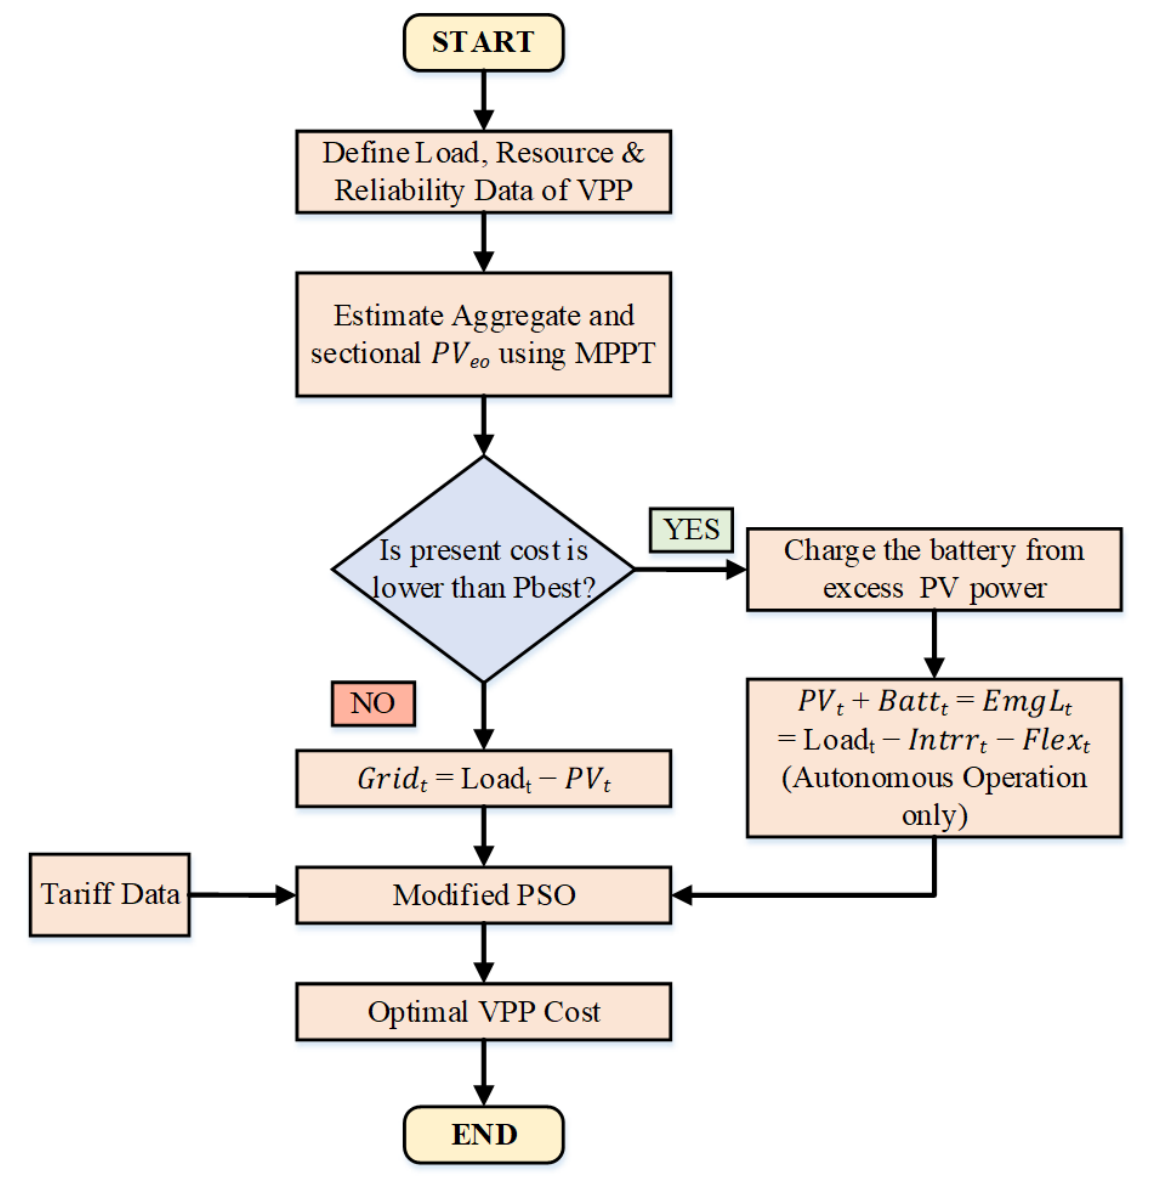
Figure 5. Dispatch Strategy of VPP.